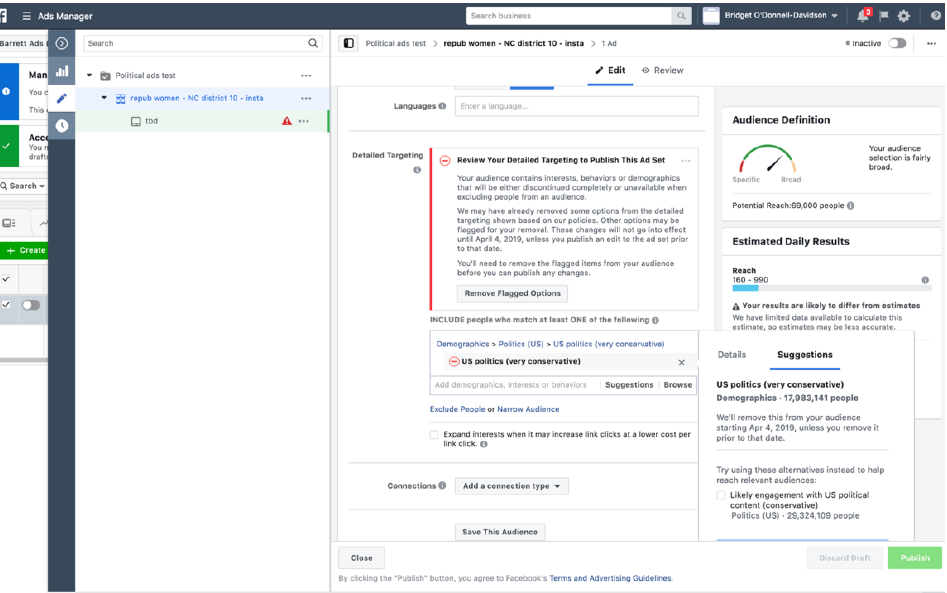
Figure 12: Screenshot from US Facebook ad buying interface, 14 March 2019. Audience segments being